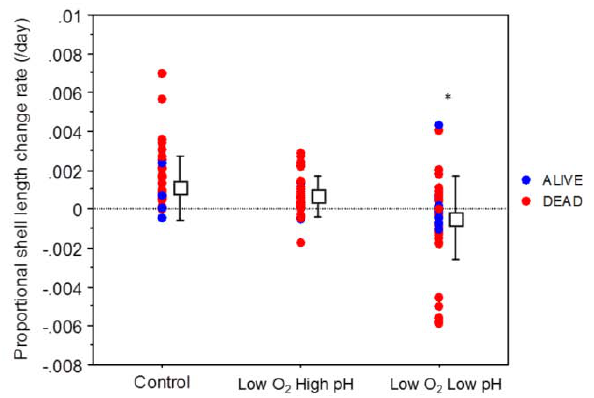
Fig. 3. Haliotis rufescens : daily proportional change in shell length (mean ± s.e.) of juveniles among control, upwelling, or low-oxygen